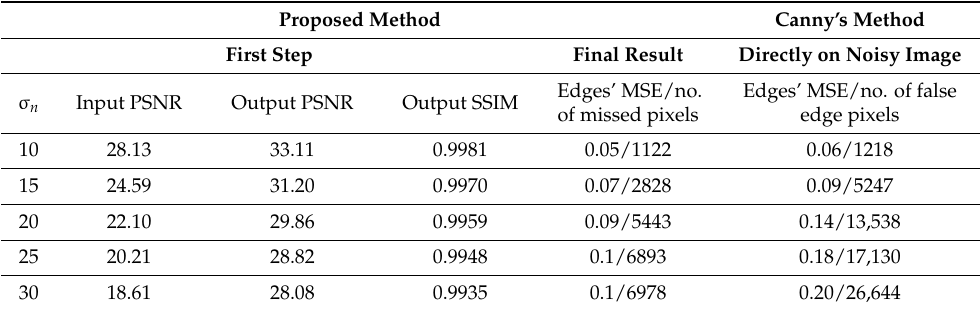
Table 2. Image Boat. A comparison of the results obtained for the proposed method and for Canny’s edge detector directly applied to the noisy image, for different values of the noise standard deviation.